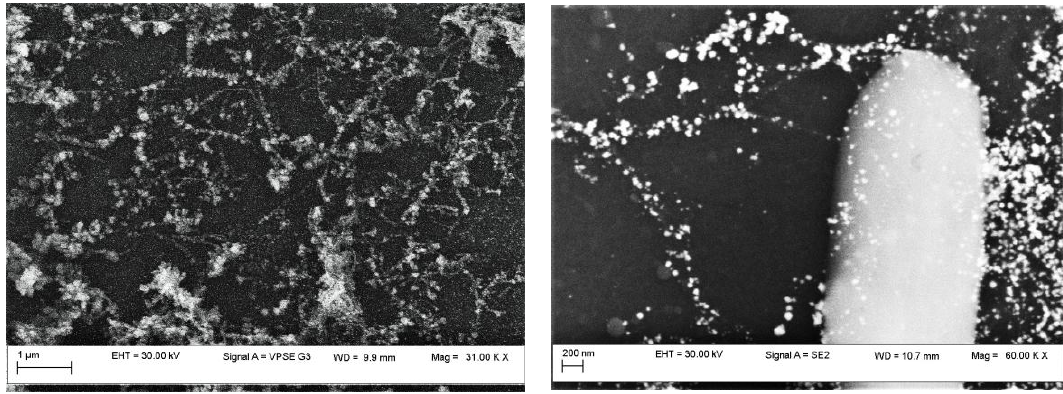
Figure 3. SEM image of a section of the sensor structure (mag: left: 31 and right: 60 KX).